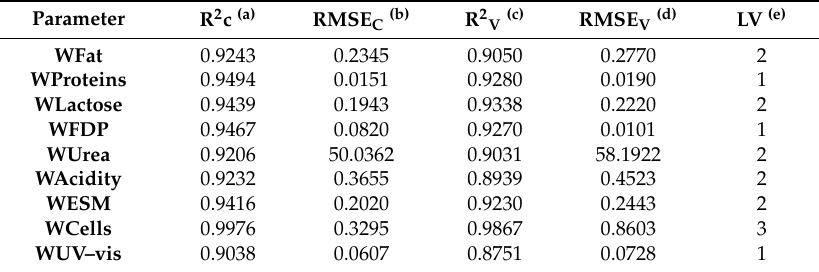
(a) Squared correlation coefficient in calibration; (b) root mean square error of calibration; (c) s quared correlation coefficient in validation; (d) root mean square error of validation; (e) latent variables.